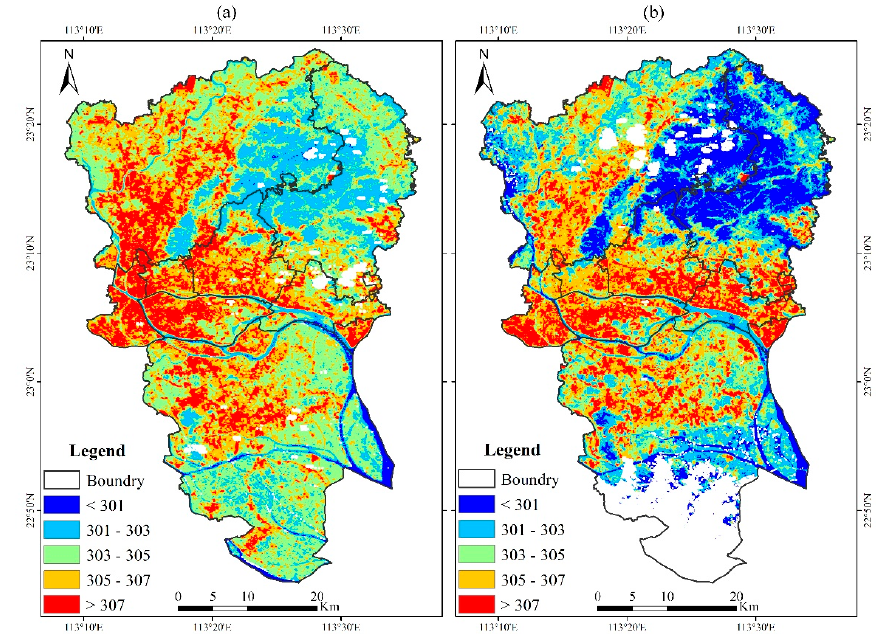
Figure 6. Spatial distribution of LST (Kelvin) on 26 July 2008 ( a ) and on 22 July 2018 ( b ) in the study area.